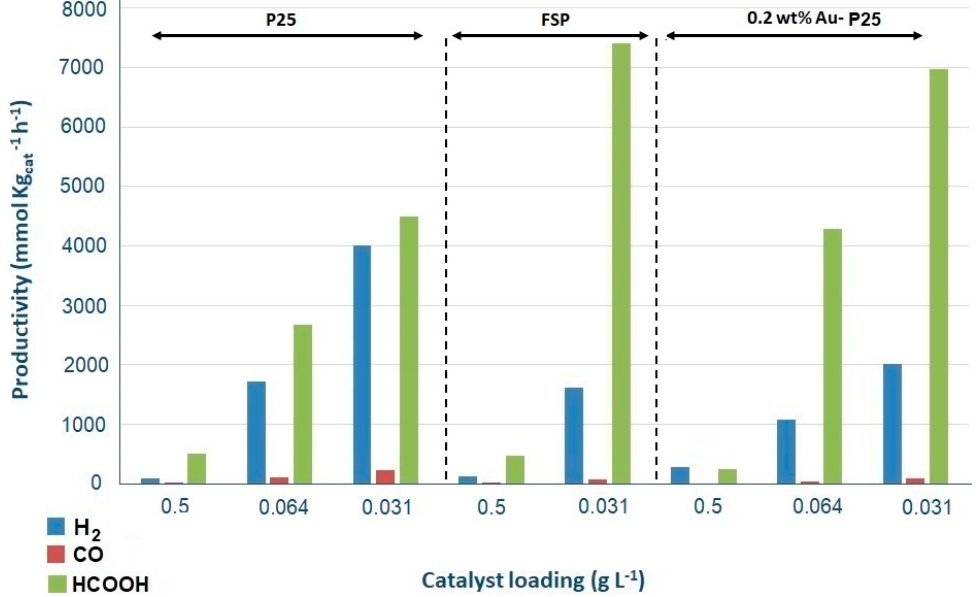
Figure 10. Products productivity with respect to different catalysts in different loadings with HS = 1.66 g L − 1 and at pH = 13/14.